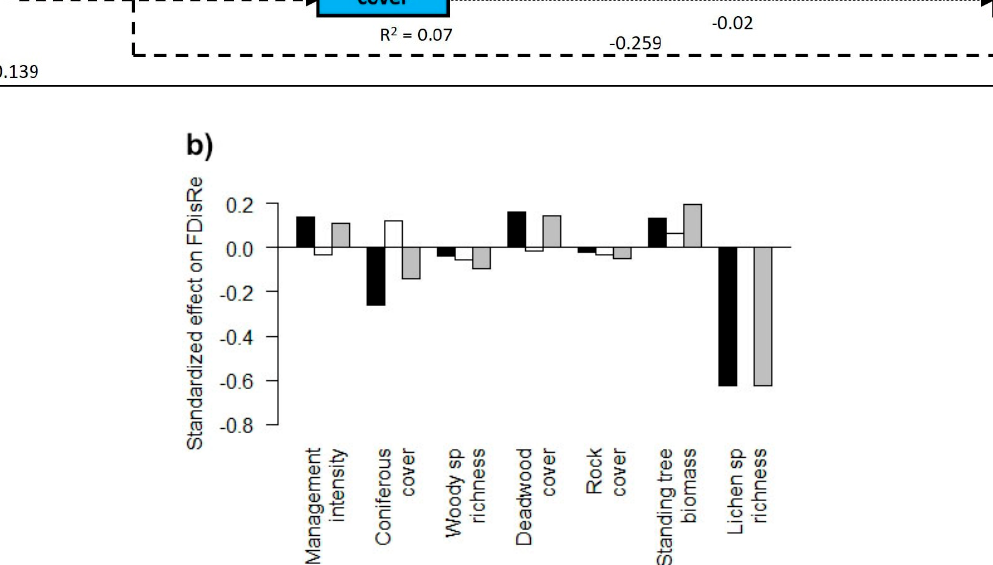
Figure 5. Effects of forest management and environmental variables on the functional diversity index based on reproduction-, dispersal- and establishment-related traits (FDisRe). ( a ) Structural equation model depicting the direct and indirect effects of forest management and conifer cover (orange boxes) on environmental variables (blue boxes) and lichen biodiversity (green boxes). Functional diversity was calculated for reproduction-, dispersal- and establishment-related traits (FDisRe). Single-headed arrows indicate a direct effect of a given variable on another. Double-headed arrows indicate a mutual dependency between two variables. Numbers adjacent to the arrows show standardized path coefficients; the widths of the lines are proportional to the size of the path coefficients. Solid lines indicate positive and dashed lines negative relationships. Asterisks next to the path coefficients indicate p -values: ***, p < 0.001; **, p < 0.01; no asterisk, p ≥ 0.05 (n.s.). The dashed arrows show co-variances between factors. R 2 values denote the proportion of variance explained for the endogenous variables. ( b ) Direct effects (black bars), indirect effects (white bars) and standardized total effects (direct × indirect effect; grey bars) of all factors on FDisRe, derived from the structural equation models.